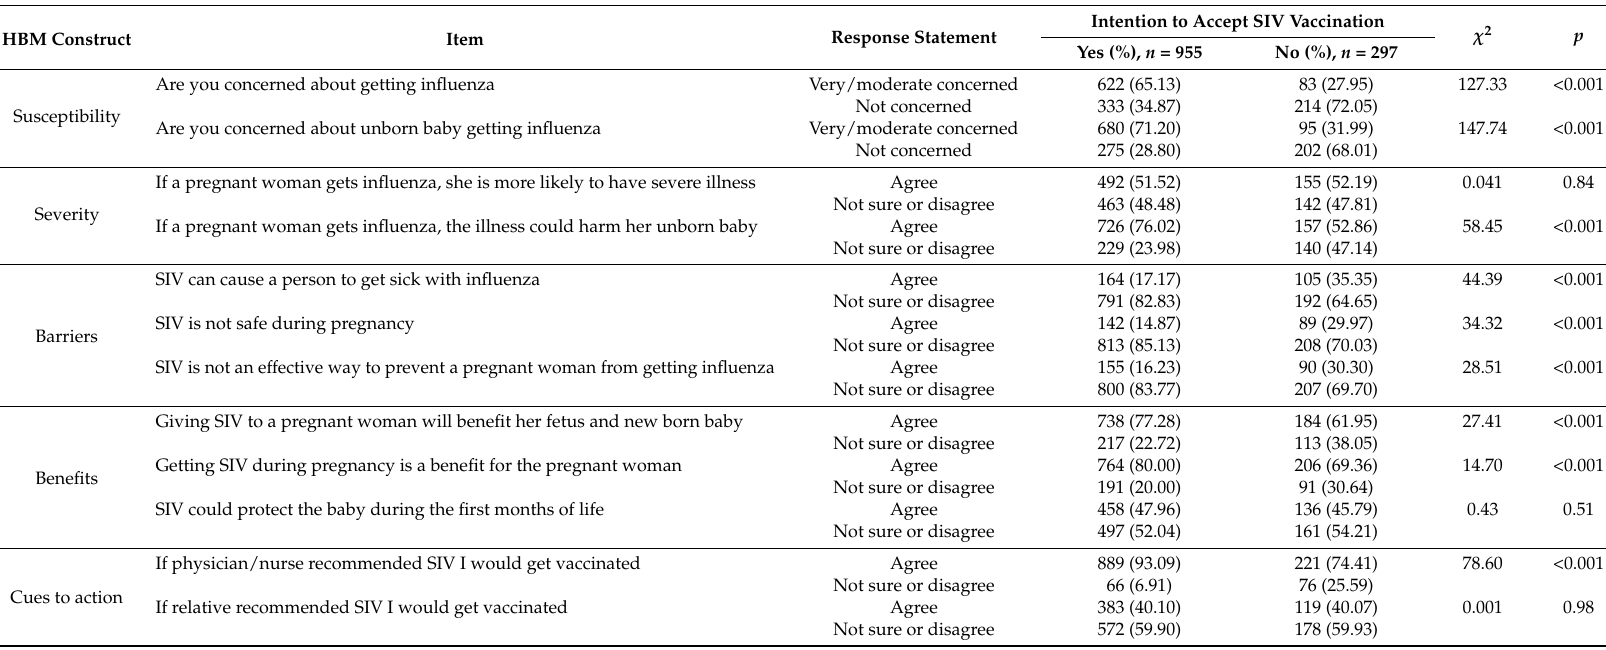
Table 2. Comparison of the proportion of pregnant women who agreed with various health beliefs by acceptance of SIV, in Zhejiang province,